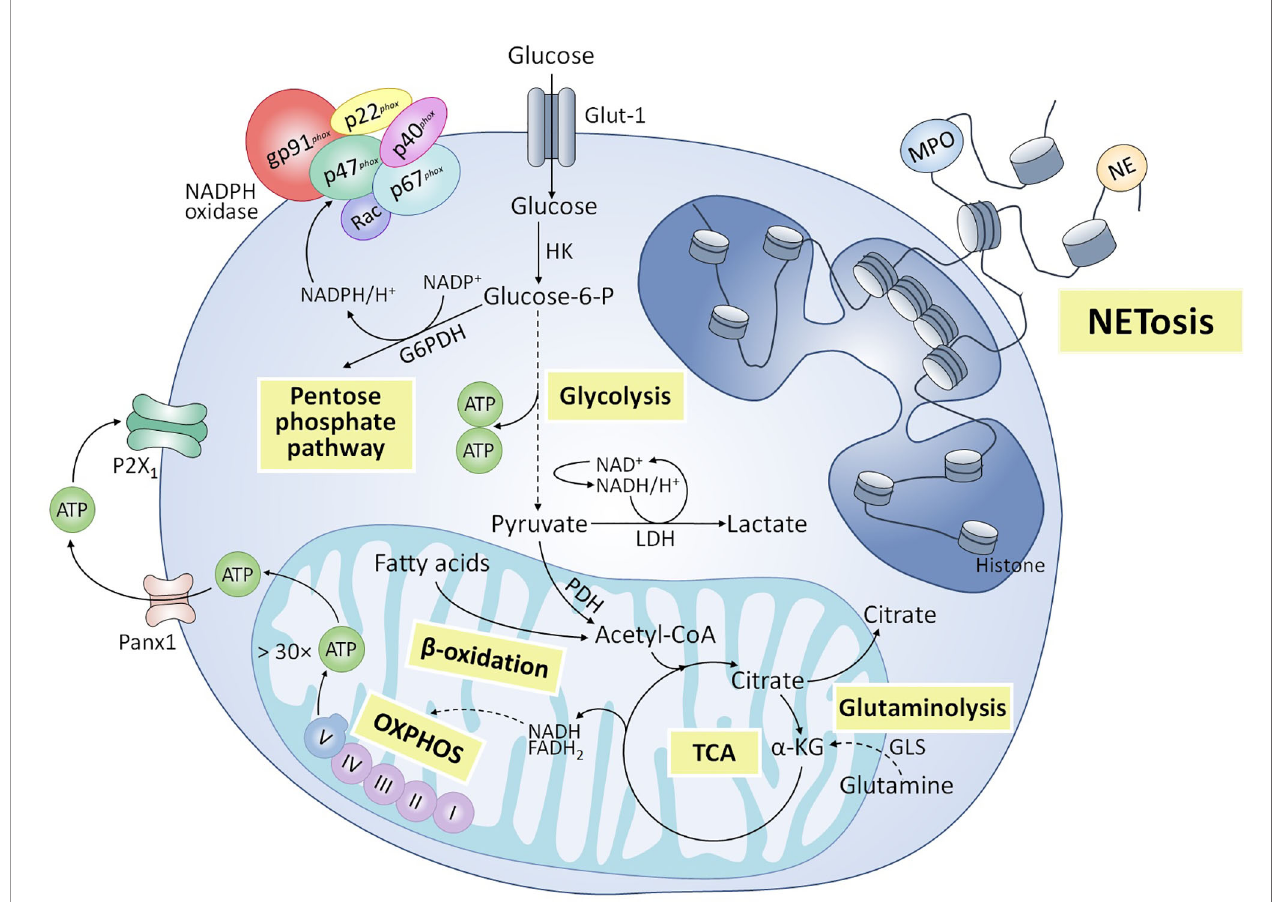
FIGURE 2 | Metabolic pathways involved in NETosis. Various metabolic routes have been implicated in the release of NETs. Glycolysis is an essential metabolic pathway for NADPH oxidase-dependent and -independent NETosis triggered by various stimuli. Pentose phosphate pathway has also been shown to participate in classical NETosis, by providing the NADPH necessary to produce reactive oxygen species (ROS) by the NADPH oxidase complex. Other metabolic pathways associated with mitochondrial activity also appear to be partially involved in NET formation, including hydrolysis of glutamine by glutaminase (GLS) and subsequent anaplerotic reactions to form a -ketoglutarate ( a -KG) that enters the tricarboxylic acid (TCA) cycle, and b -oxidation offatty acids to supply acetyl-coenzyme A (CoA) to the TCA cycle. In addition, the adenosine triphosphate (ATP) synthesized in mitochondria as a product of oxidative phosphorylation (OXPHOS) would be released into the extracellular space through pannexin 1 (Panx1) channels and would enhance NET formation through purinergic signaling mechanisms dependent on P2X 1